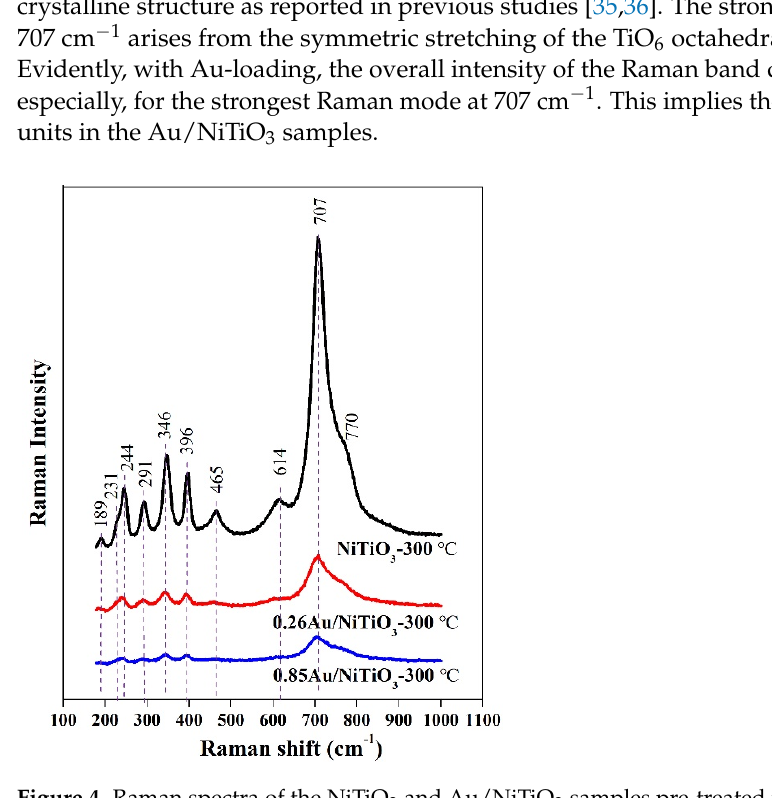
3 and Au/NiTiO 3 samples pre-treated in H 2 at 300